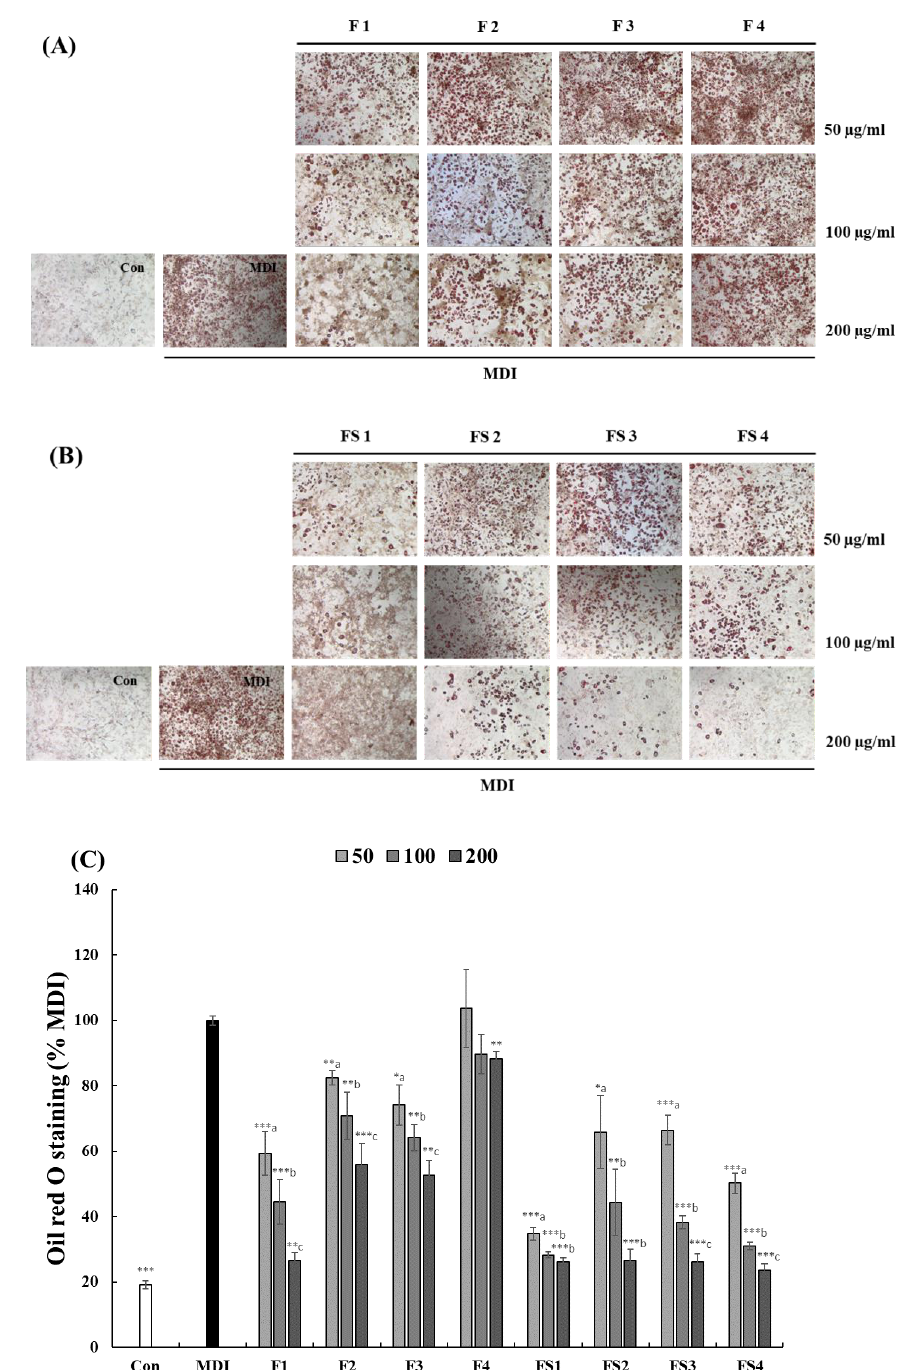
Figure 3. Effect of Cornus officinalis fruit extracts (50, 100, and 200 µg/mL) on oil red O staining in 3T3-L1 cells. Effect of Cornus officinalis on fat droplet formation in 3T3-L1 cells. ( A ) Pericarp, ( B ) pericarp + seeds, and ( C ) quantification of oil red O staining. The 3T3-L1 cells were incubated for 8 days with MDI, with or without Cornus officinalis extracts. The cells were stained with oil red O and examined under a light microscope. Relative lipid content was evaluated by counting oil red O-stained cells. Data are means ± SD ( n = 3). * p < 0.05; ** p < 0.01; *** p < 0.001. Significant difference by the two-sample Student’s t -test between non-treated (MDI) and treated cells. Different small letters on the bars indicate a significant difference ( p < 0.05) among concentrations of the same samples. Samples are listed in Table 1. MDI: methylisobutylxanthine, dexamethasone, and